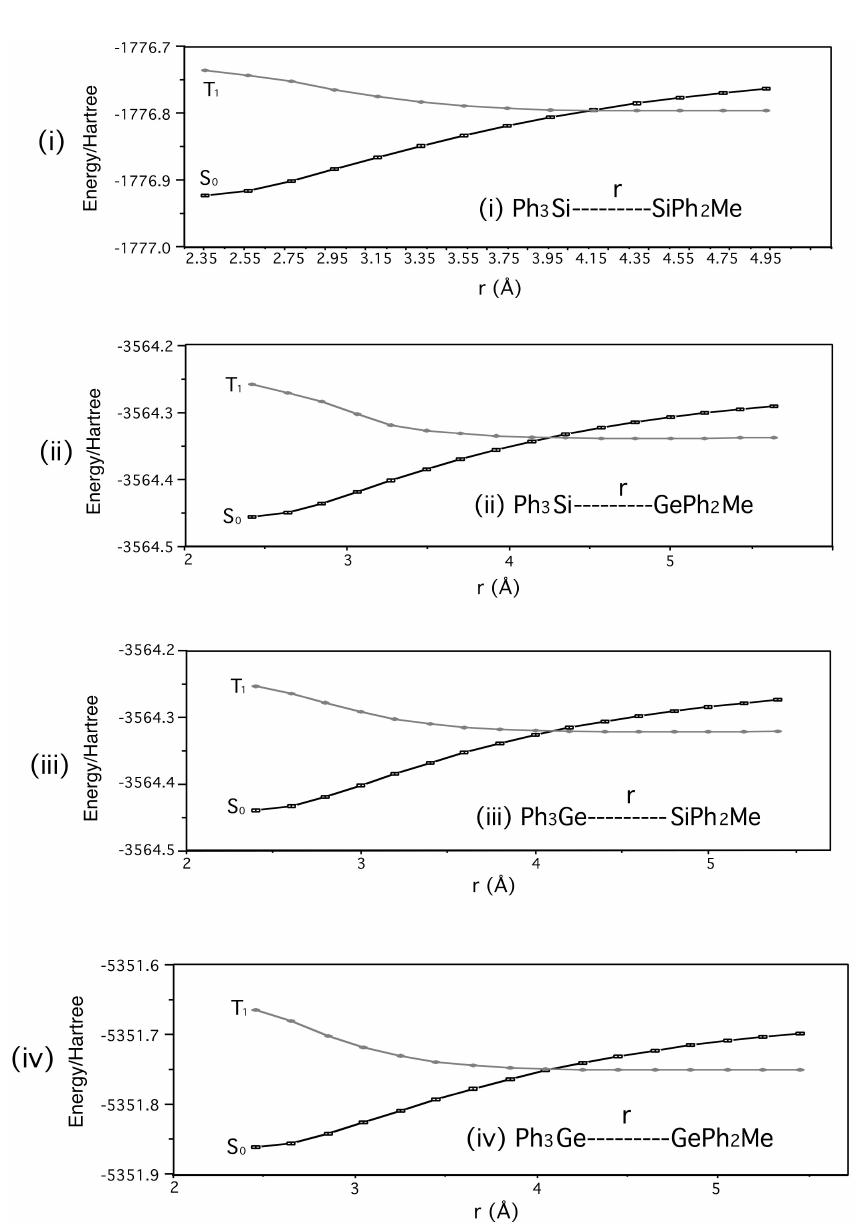
Figure 2. The minimum-energy pathway for a M–M (cid:48) bond cleavage in Ph 3 M–M (cid:48) Ph 2 Me (M and M (cid:48) = Si and Ge) along the distance, r, optimized for the S 0 and T 1 states at the M06-2X/6-311G(d) level of